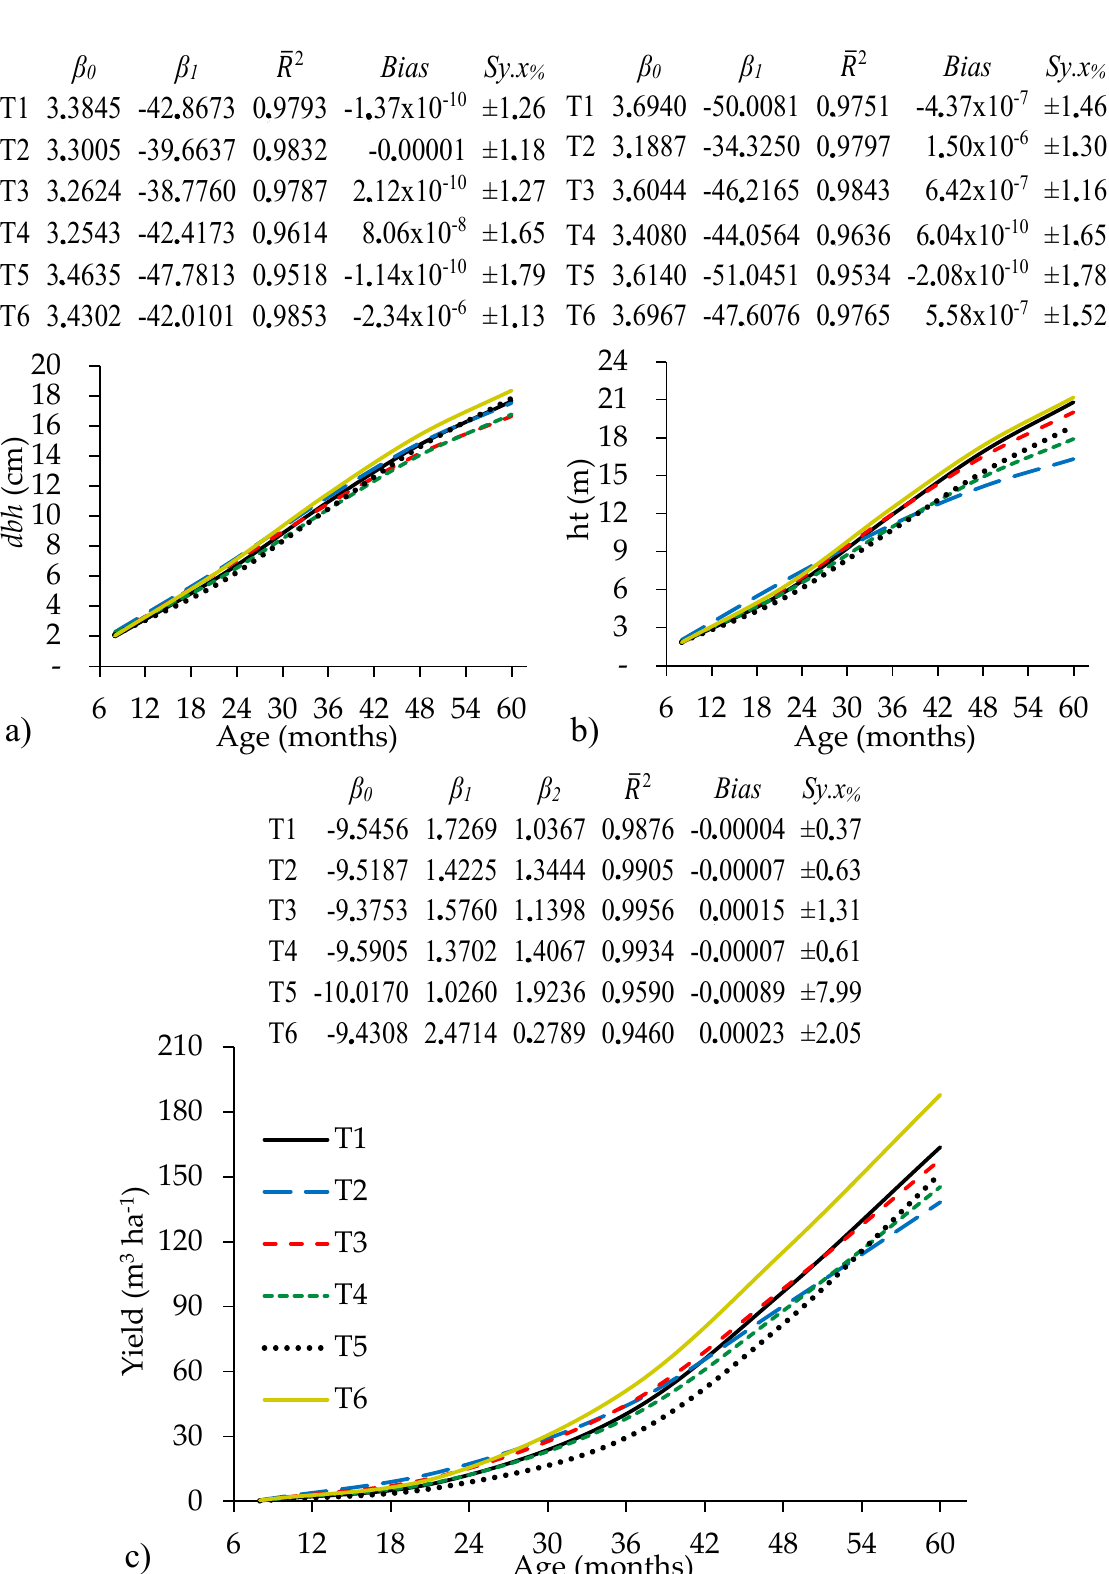
Figure 4. Estimates and growth trends in diameter at breast height ( dbh ) (a) total height ( th ) (b) and Yield (m 3 ha − 1 ) (c) of trees of paricá, submitted to soil management practices. β 0 , β 1 and β 2 = regression coefficients; Ŕ 2 = adjusted coefficient of determination; Bias ; Sy.x % = residual standard error. Trees and species destined for the sale of standing wood by the dbh class center and market value group for the criteria and control treatments, forest management area of Fazenda Shet, Dom Eliseu, State of Pará, Brazil.